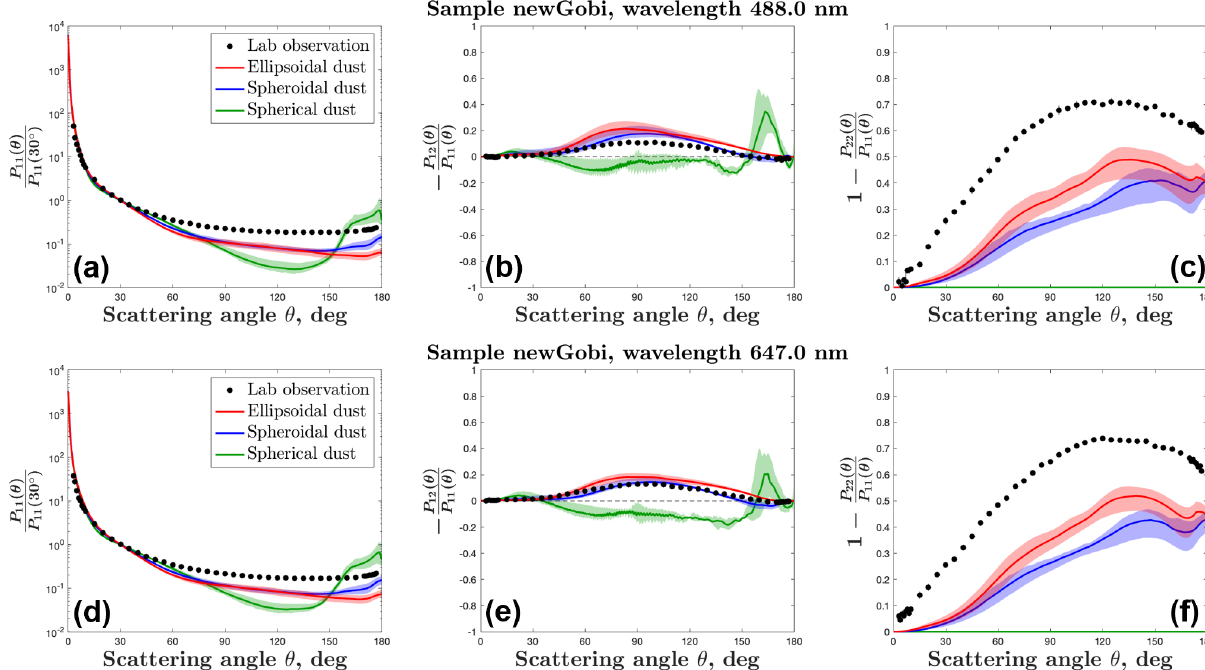
Figure 4. Same as Fig. 3, except for a comparison of the laboratory-measured scattering matrix of AGLSD dust sample newGobi against the spherical, spheroidal, and ellipsoidal dust optics simulations at the wavelengths of 488.0 and 647.0nm.